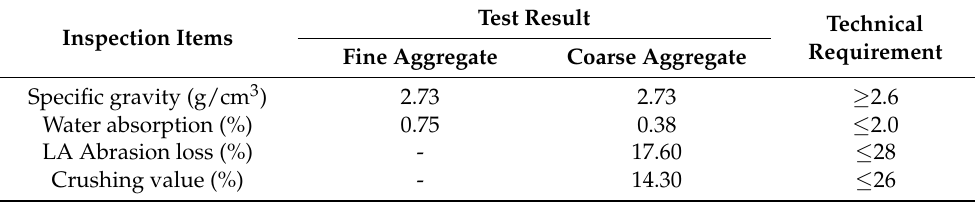
Table 4. Physical properties of